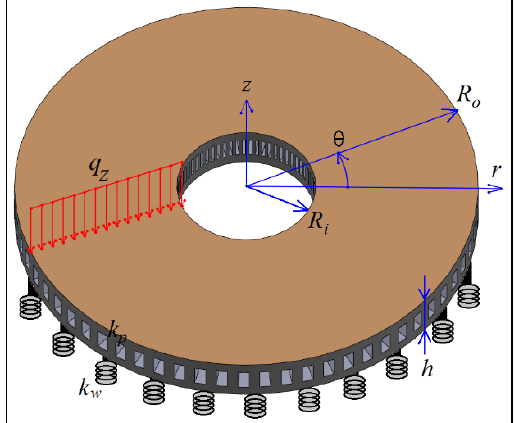
Figure 1. Schematic view of the structure.